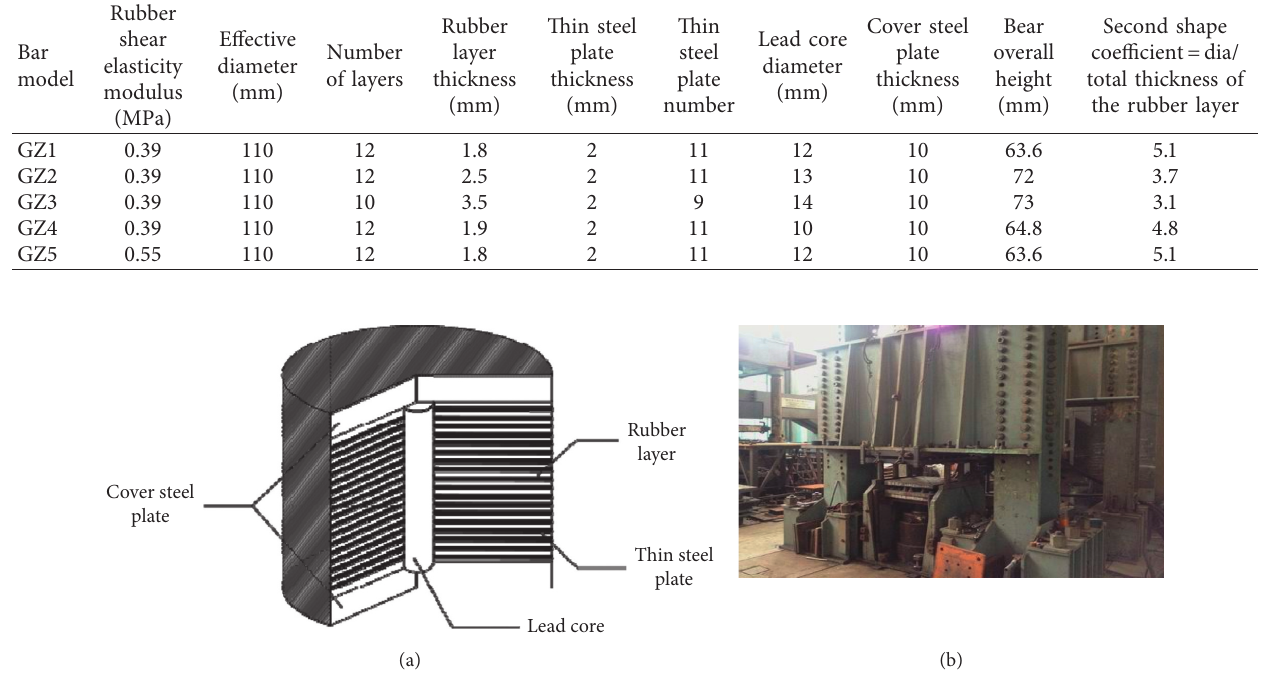
Table 1: Experimental bar specifications.